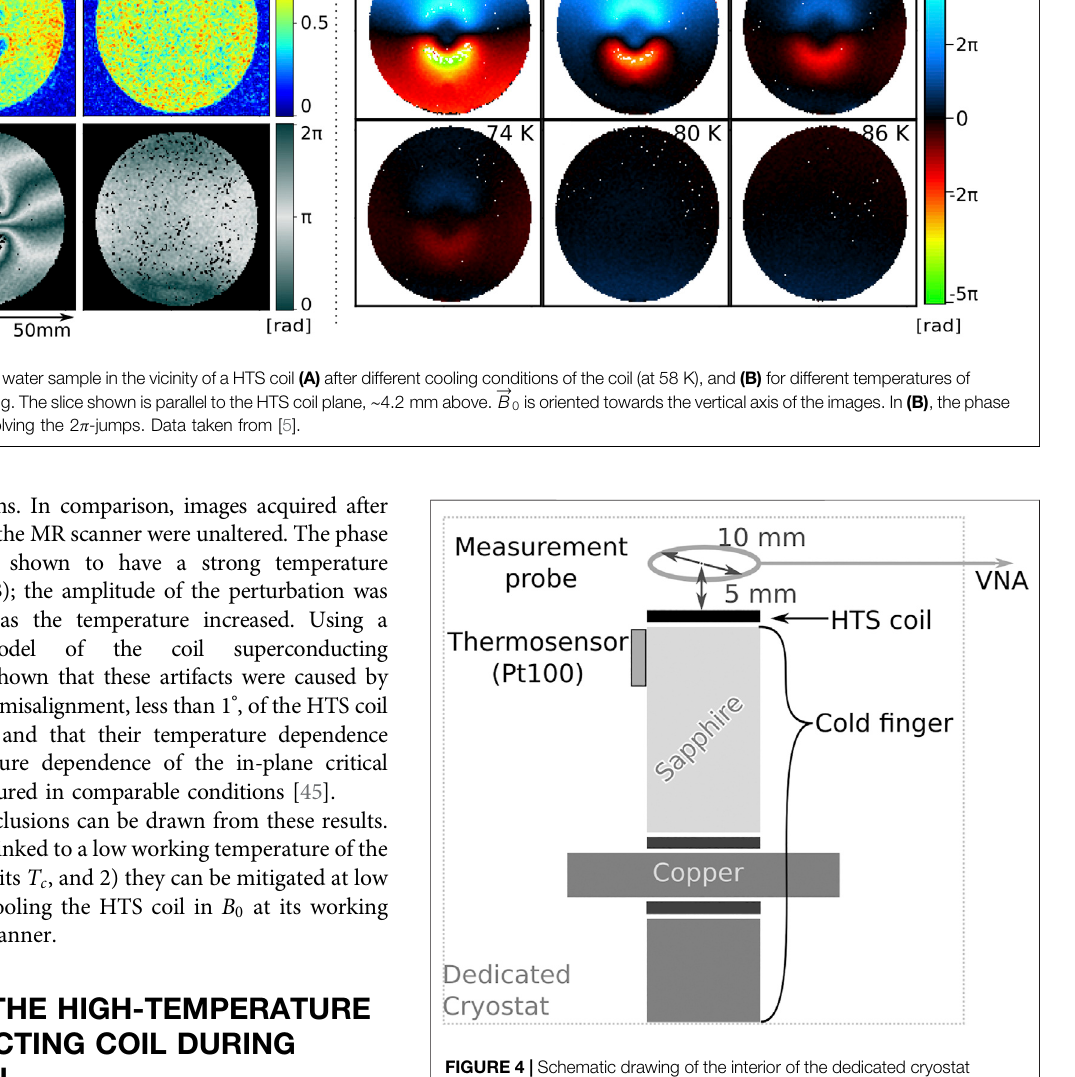
FIGURE 4 | Schematic drawing of the interior of the dedicated cryostat used in Setup 1.The VNA is connected to a measurement probe inductively coupled to the HTS coil, which is secured on a cold fi nger. The temperature is monitored using a thermosensor (Pt100). The system was fully described by